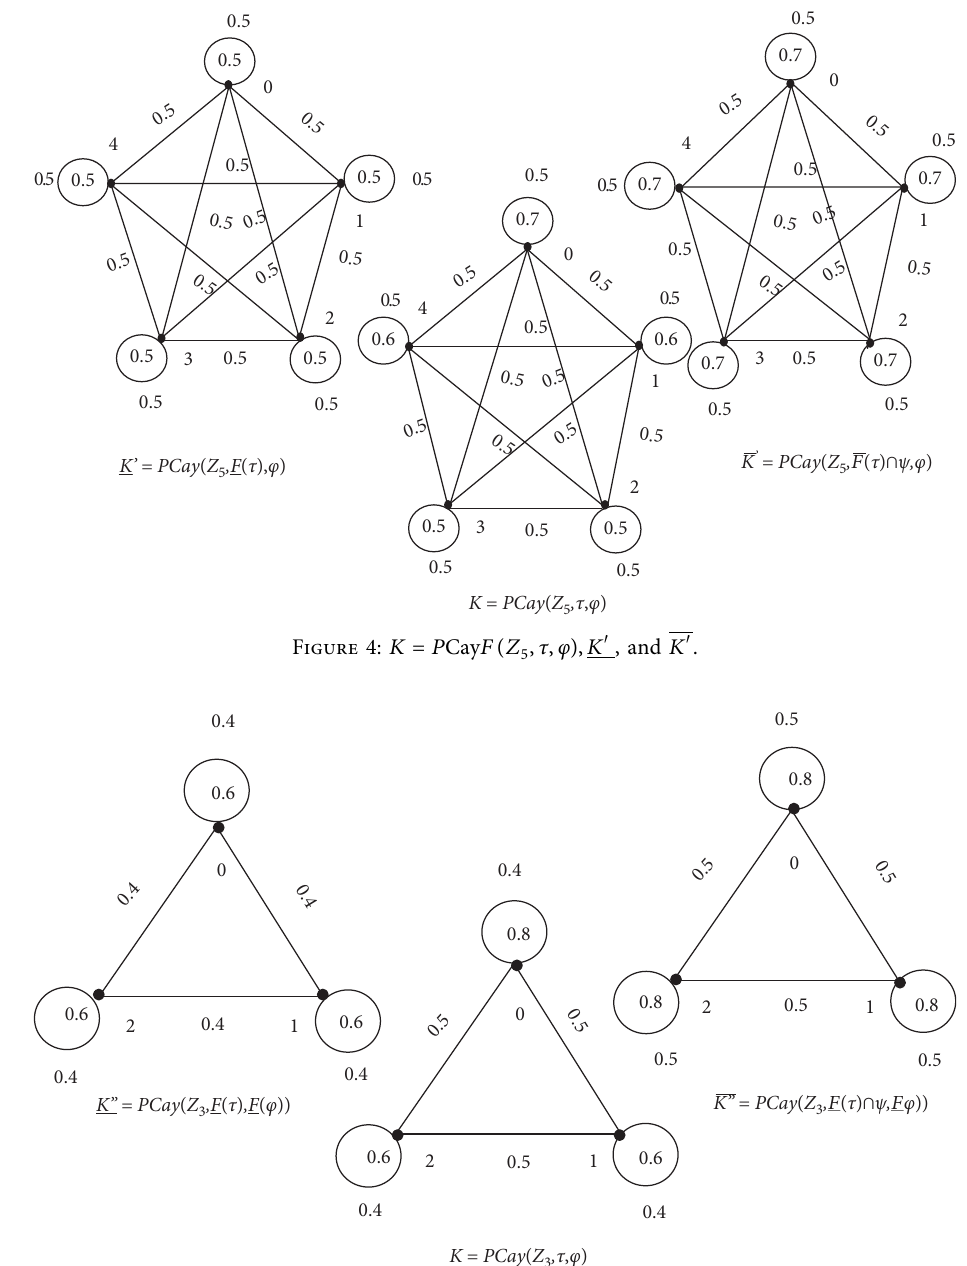
Figure 5: K � P Cay ( Z